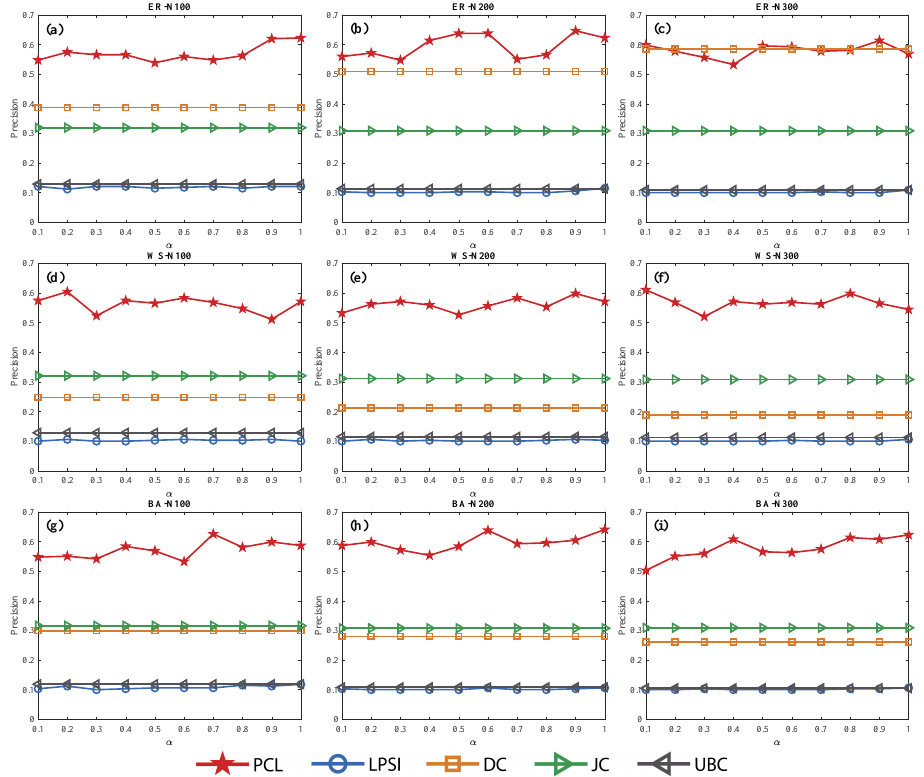
Figure 7. Sources localization accuracy of different network scale with five methods in synthetic networks. ( a – c ) Results in ER network. The scale of the network is N = 100,200,300 respectively, the average degree is < k > = 4. ( d – f ) Results in WS network. ( g – i ) Results in BA